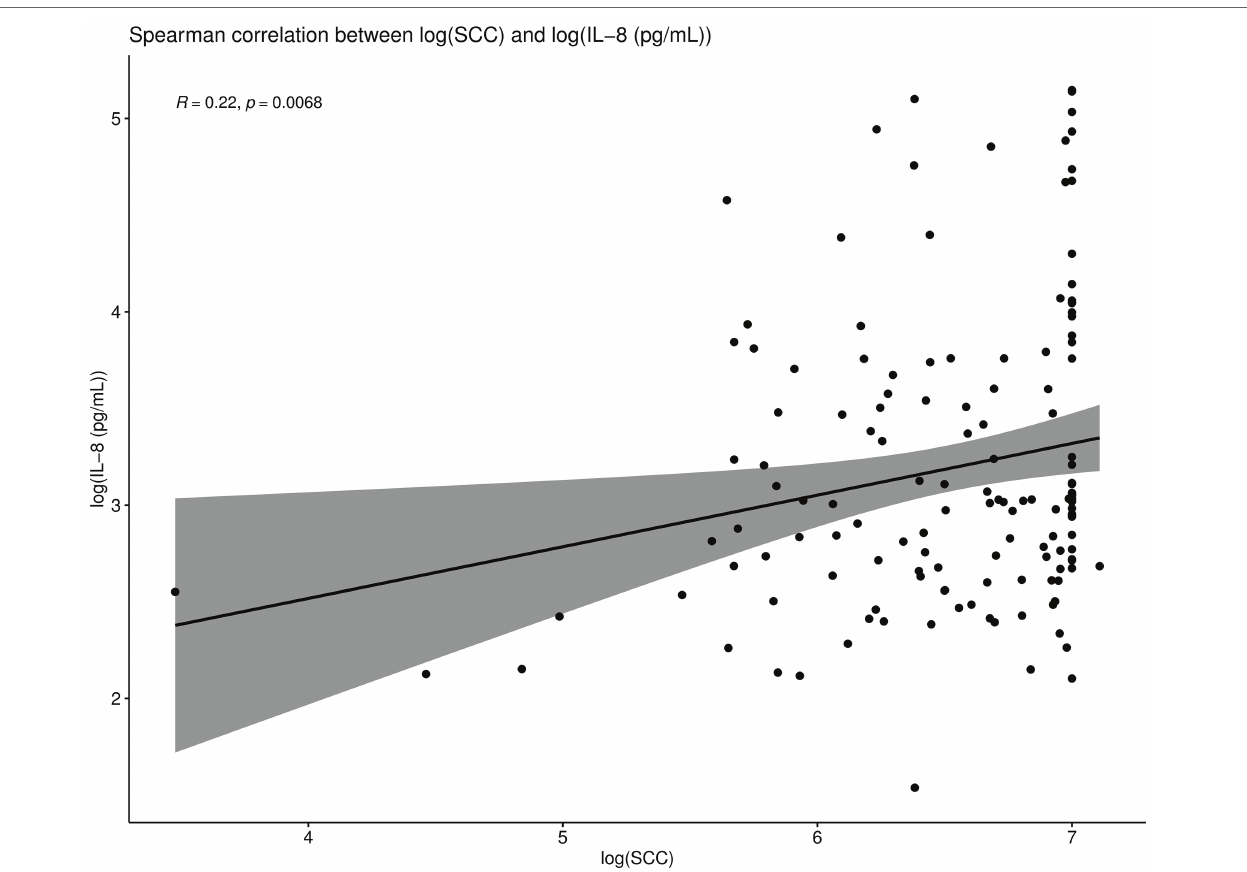
FIGURE 6 | Spearman correlations were conducted between IL-8 values and SCC values. When compared overall, SCC and IL-8 are positively and significantly correlated ( R = 0.22, p <